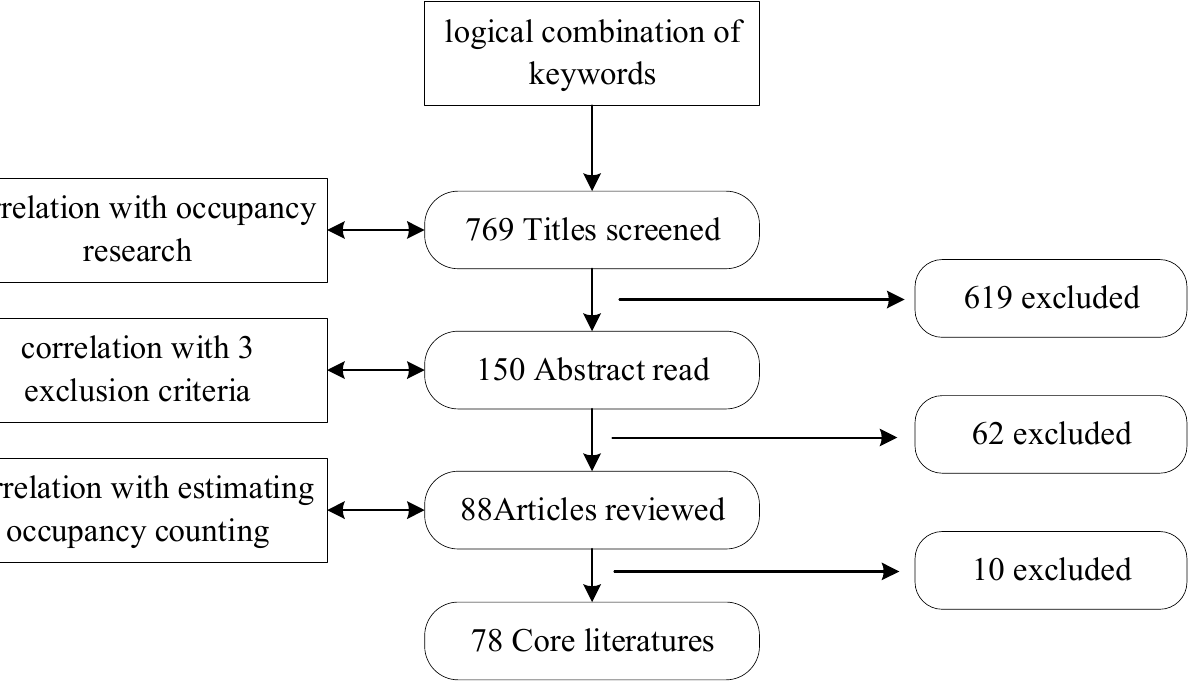
Figure 2. Systematic literature review flowchart.